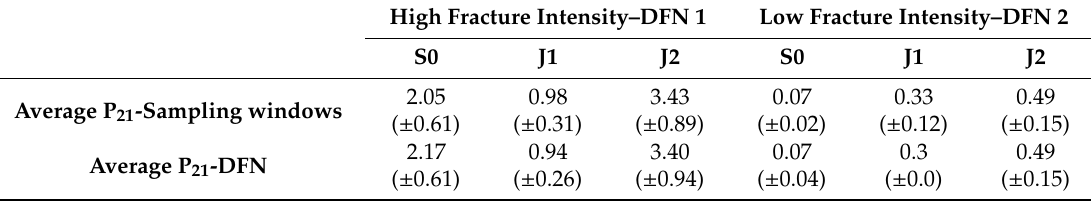
Table 2. Comparison between P 21 values and relative standard deviation (in brackets, calculated excluding minimum and maximum values) obtained from fracture analyses undertaken on the UAV-extracted sampling windows and DFN.